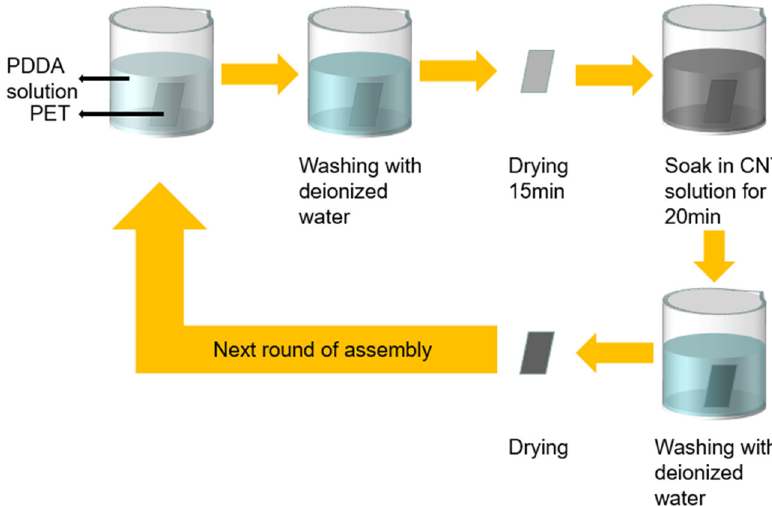
Figure 1: Assembly fl owchart of self - assembly CNT fi